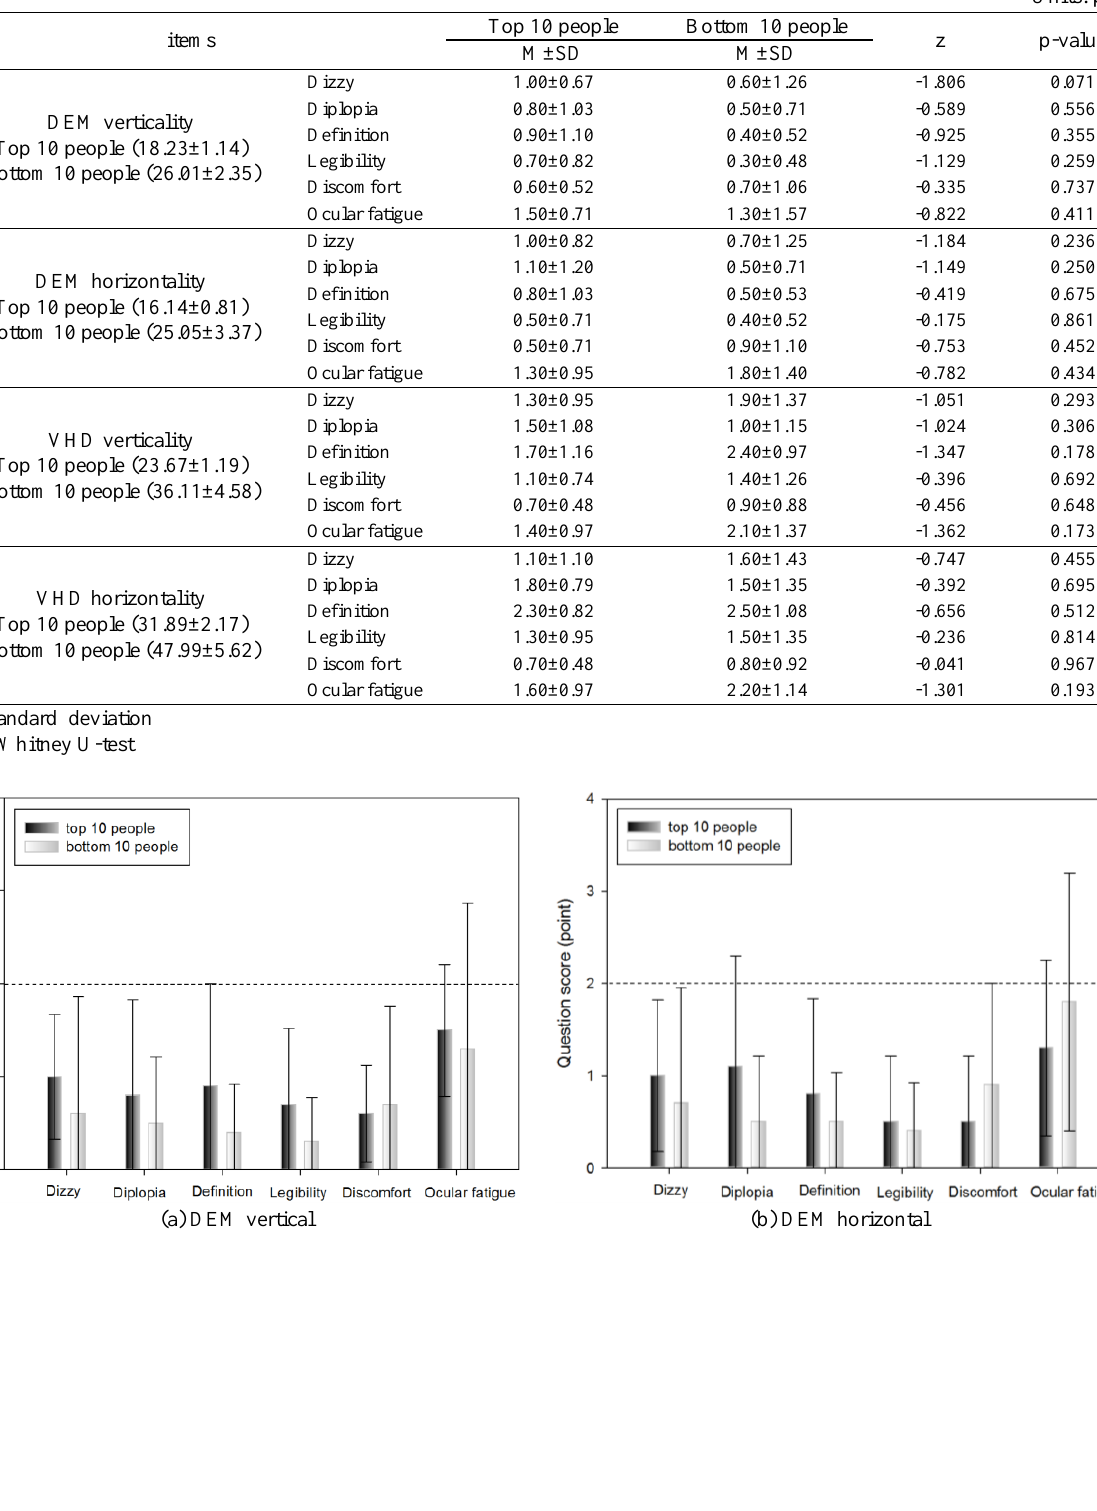
Table 10 Subjective symptoms of the top 10 and bottom 10 people within DEM and VHD items DEM verticality Top 10 people (18.23±1.14) Bottom 10 people (26.01±2.35)